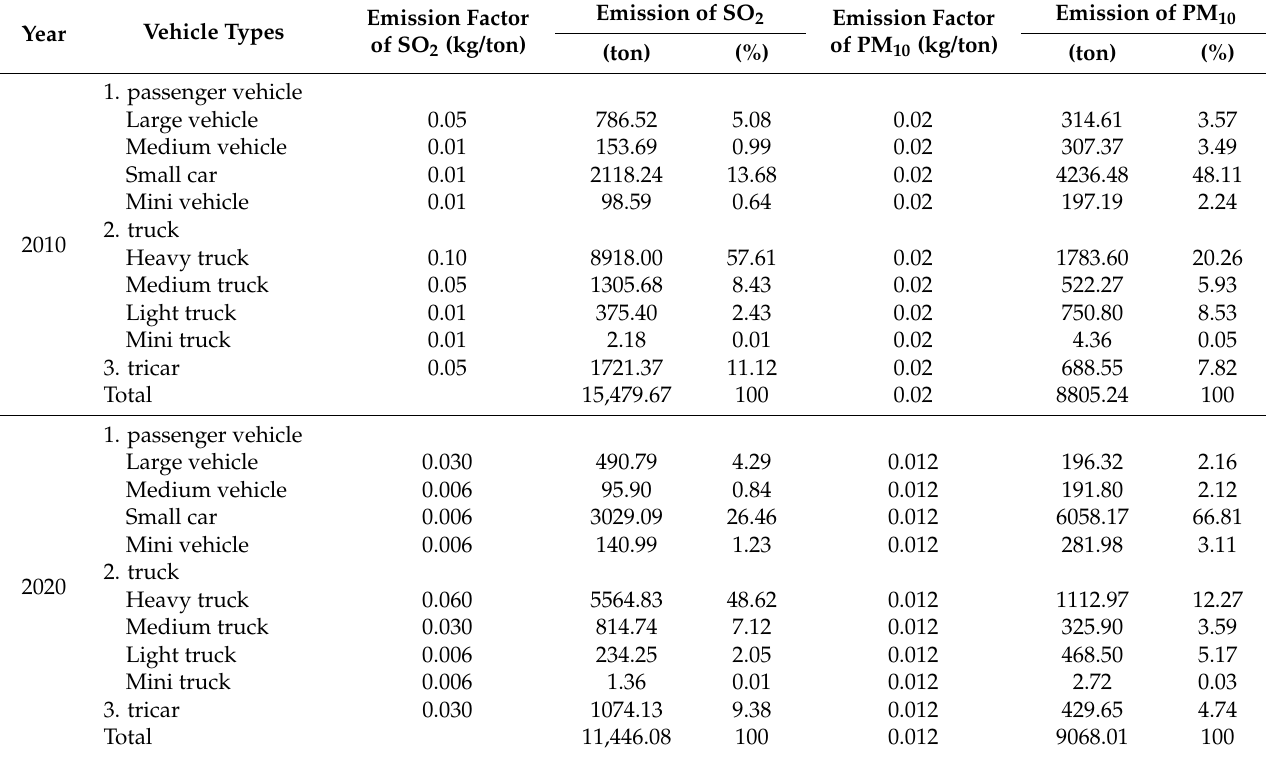
Table 2. Atmospheric emission inventory of vehicle-based transportation land sources in